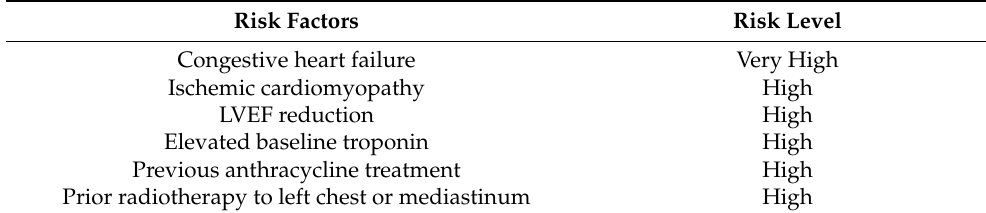
Table 2. Risk factors for anthracycline induced cardiotoxicity